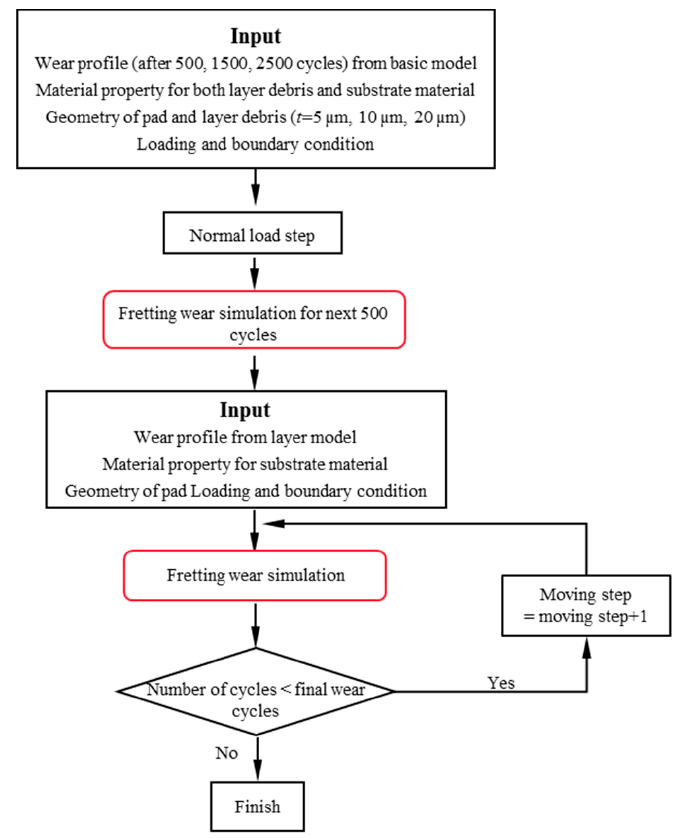
Figure 4. The flowchart of the fretting wear simulation with the debris layer.